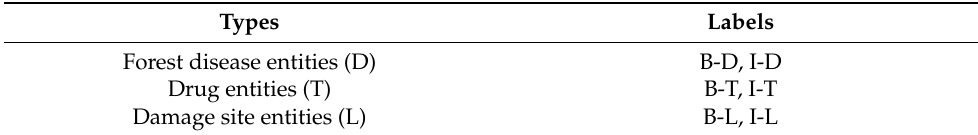
Table 1. Types of named entities.